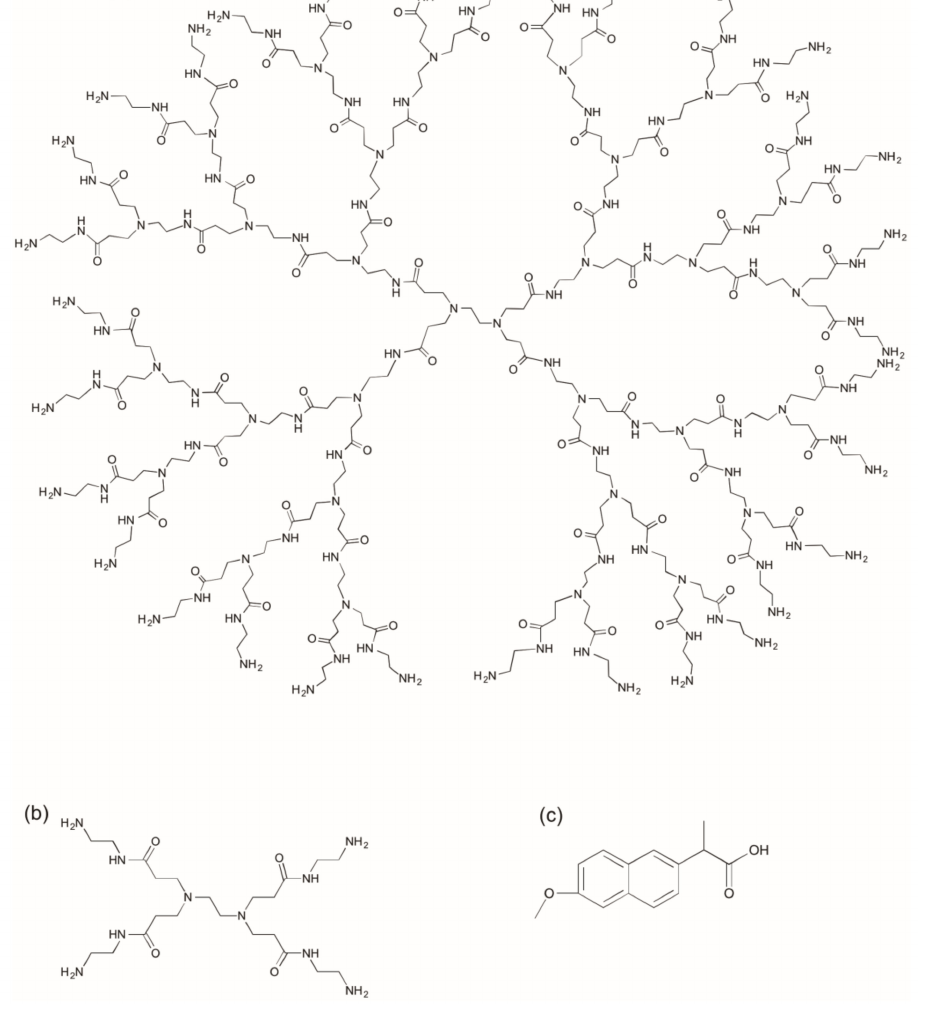
Figure 1. Structure of ( a ) G3 PAMAM dendrimer with an ethylenediamine core, ( b ) G0 PAMAM dendrimer with an ethylenediamine core and ( c )